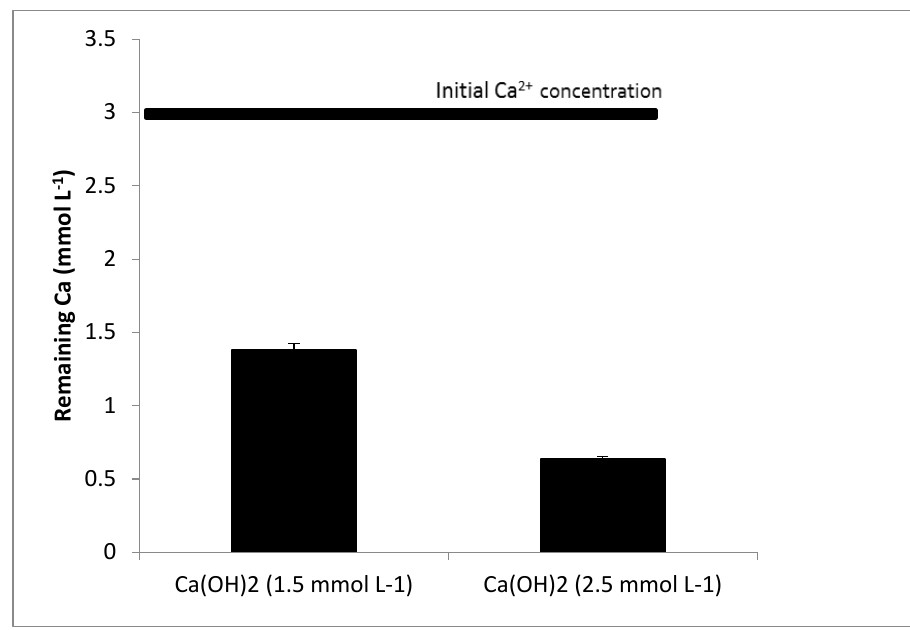
Figure 2. Calcium removal with calcium hydroxide.